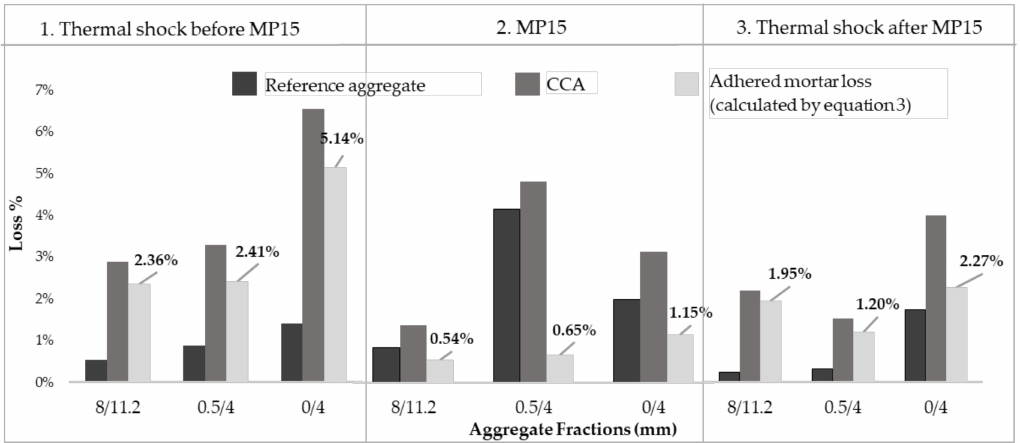
Figure 2. Adhered mortar loss by mechanical pre-processing